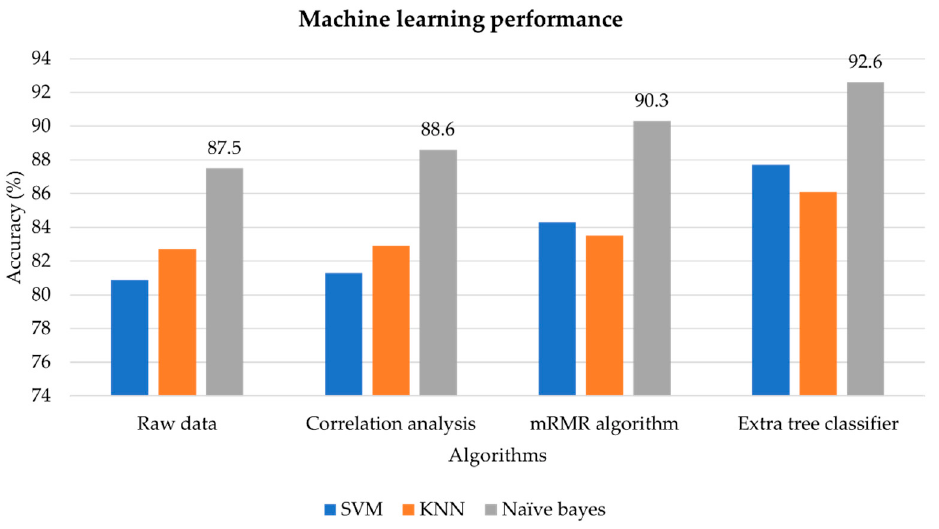
Figure 21. Machine-learning performance comparison of the four data case scenarios.